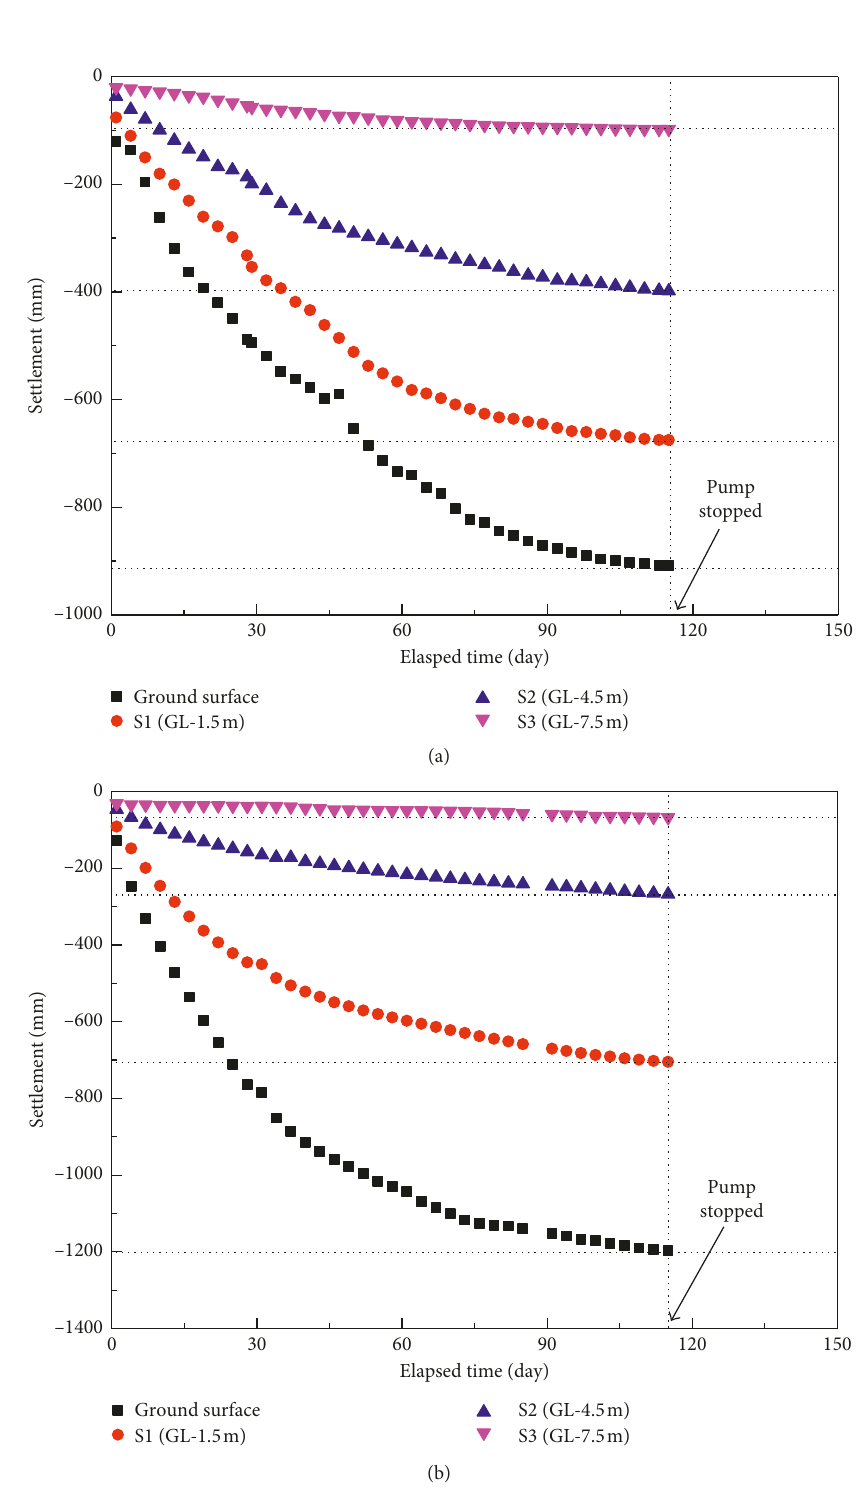
Figure 5: Settlement versus elapsed time curve. (a) Section 1 and (b) Section